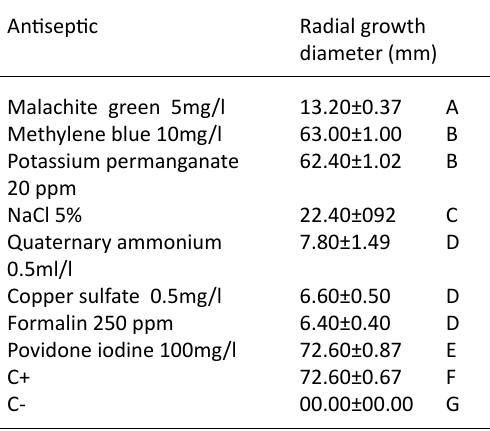
table 3. Radial growth diameter of B. sanguinis in the PDA media , for different antiseptics used and in comparison with control positive and negative group.